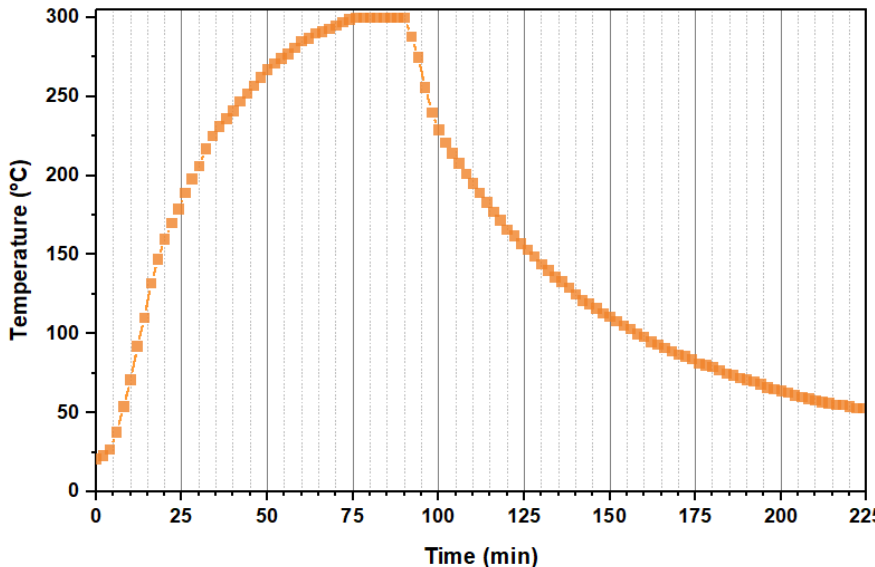
Figure 1. Temperature profile of the reaction medium during the hydrothermal synthesis of the base LiFePO 4.